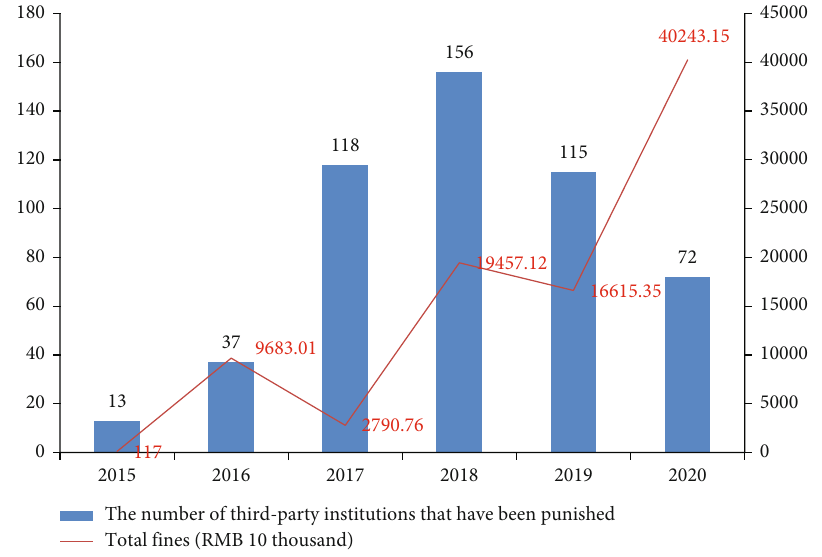
Figure 5: The economic punishment from 2015 to 2020 to the third-party